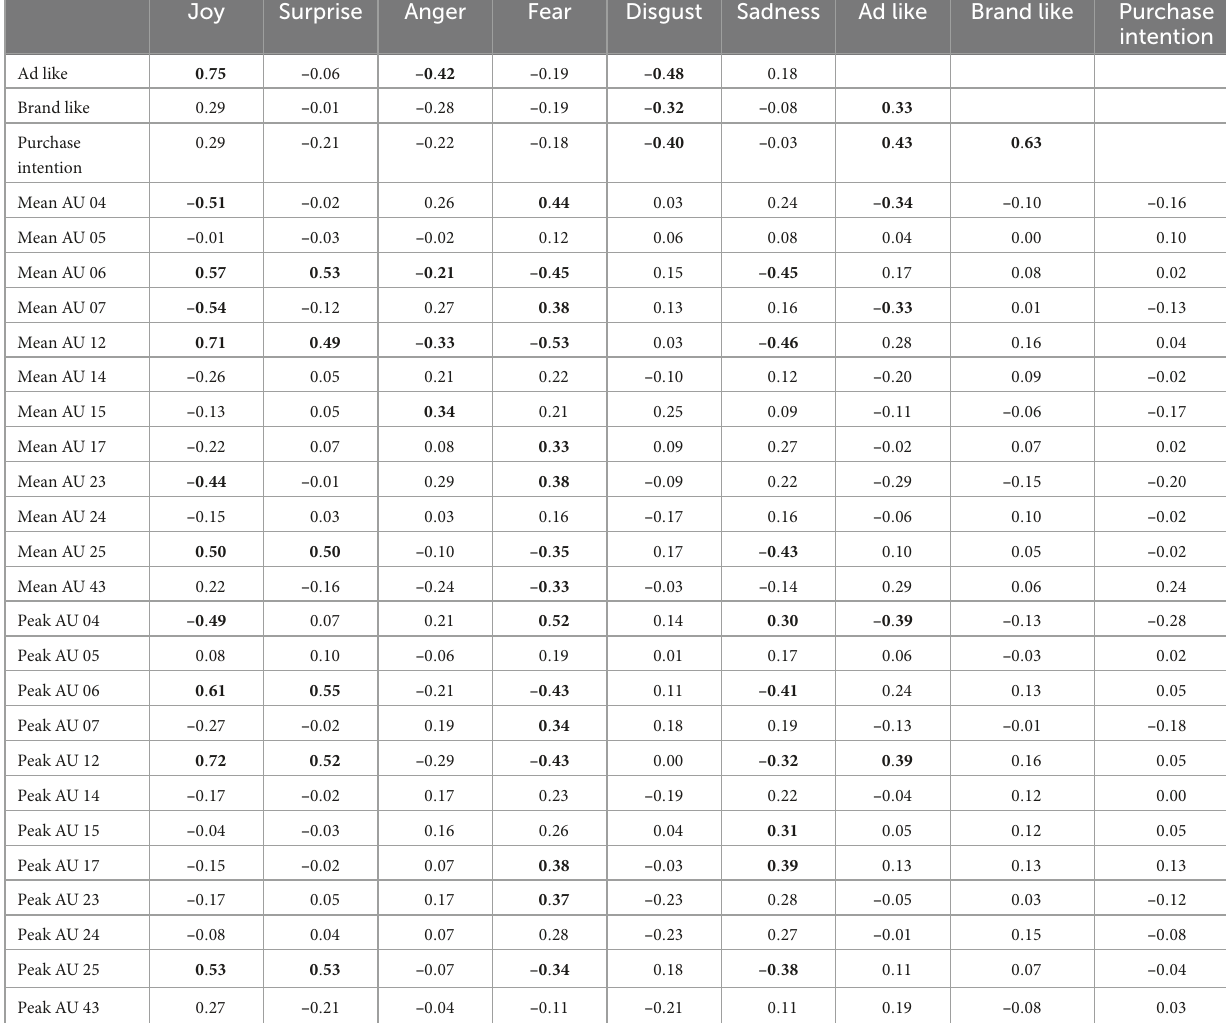
TABLE 1 Spearman correlations based on unstandardized average values per stimulus between self-report ratings and Action Unit (AU) activity (mean and